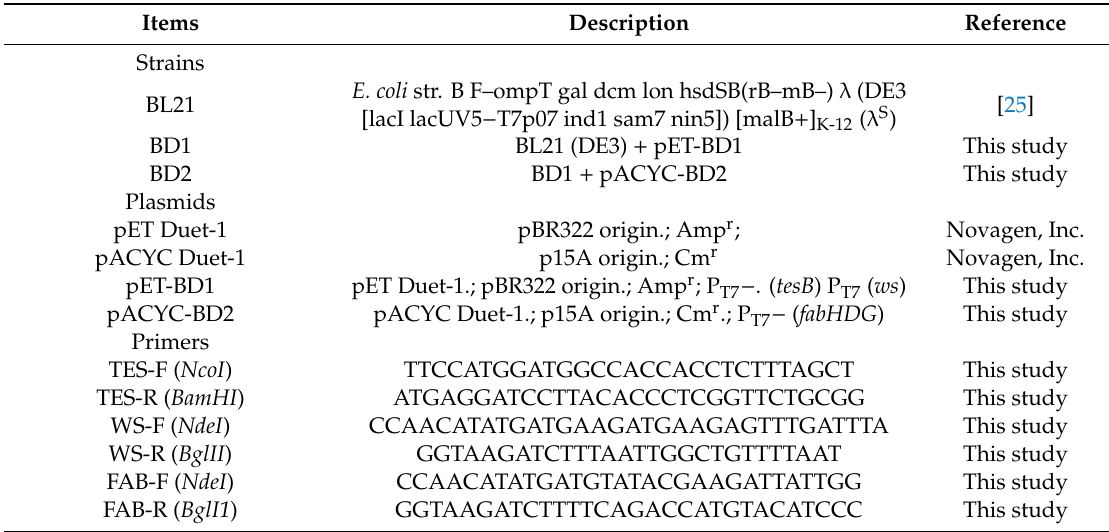
Table 1. Strains, plasmids, and